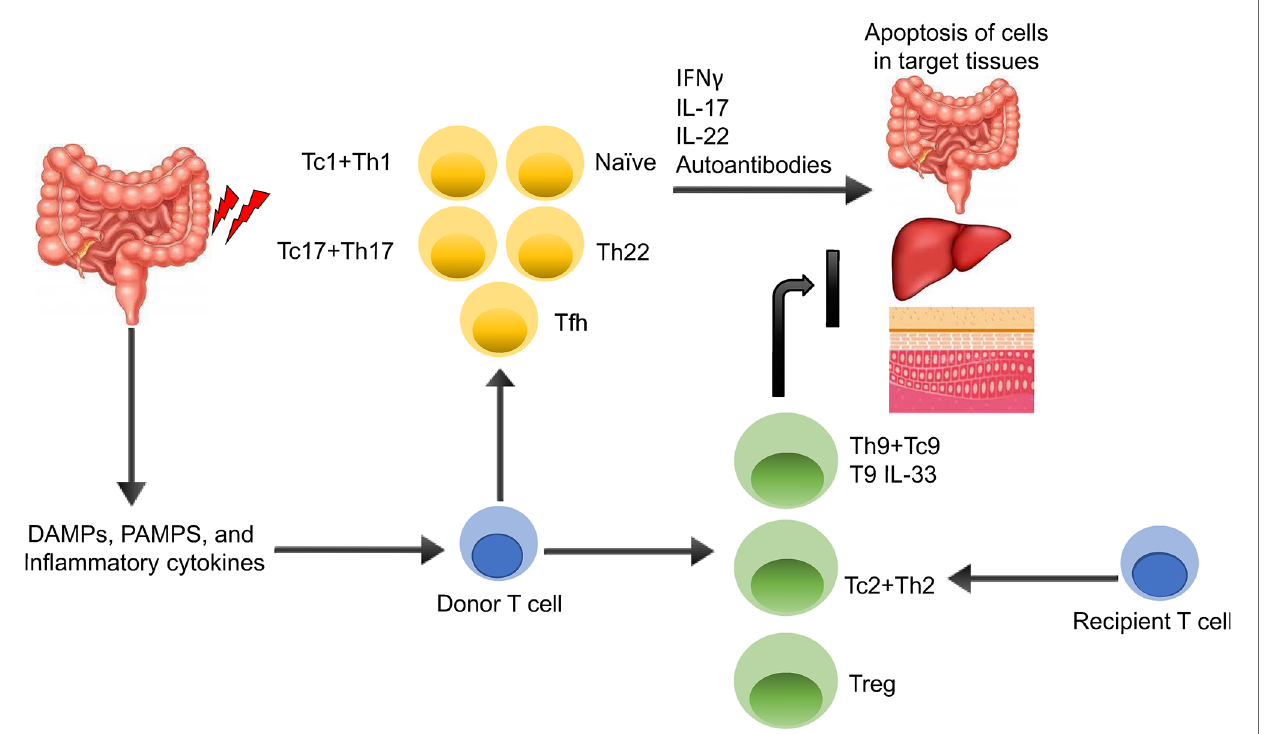
FIGURE 2 | Overview of GVHD Pathogenesis. The gut and other issues are damaged during irradiation or chemotherapy, leading to the release of various DAMPs, PAMPs, and in fl ammatory cytokines. These DAMPs, PAMPs, and cytokines activate both host and donor antigen-presenting cells (APCs), which then activate the donor T cells. The APCs are also secreting various cytokines that promotes T cell differentiation toward different T cell subsets including T helper type 1 (Th1), T helper type 2 (Th2), T helper type 17 (Th17), T helper type 9 (Th9), and regulatory T cells (Tregs). Activated Th1 and Th17 T cells are able to secrete various pro- in fl ammatory cytokines including IFN g , IL-17, IL-22 leading to apoptosis of cells in target tissues, mainly in the gut, liver, and skin, which can be alleviated by anti- in fl ammatory cytokine producing Th2, Th9 and Treg cells, such as IL-33-producing